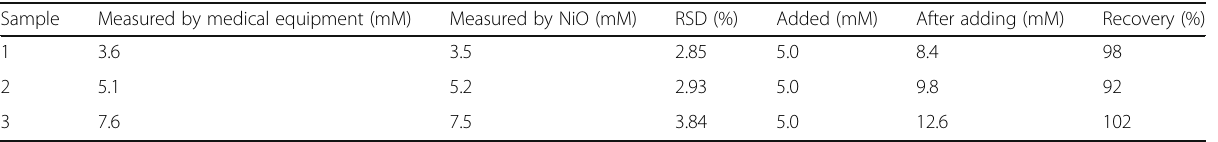
Table 2 Detection of glucose in human serum Sample Measured by medical equipment